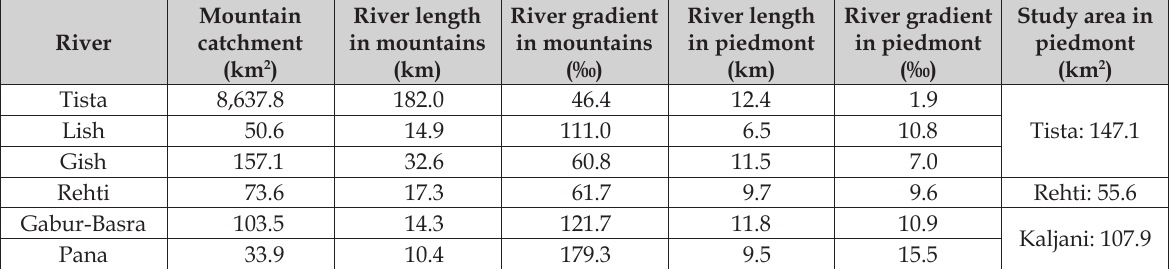
Table 1. Characteristic of rivers draining Himalayas and three study sites of piedmont.